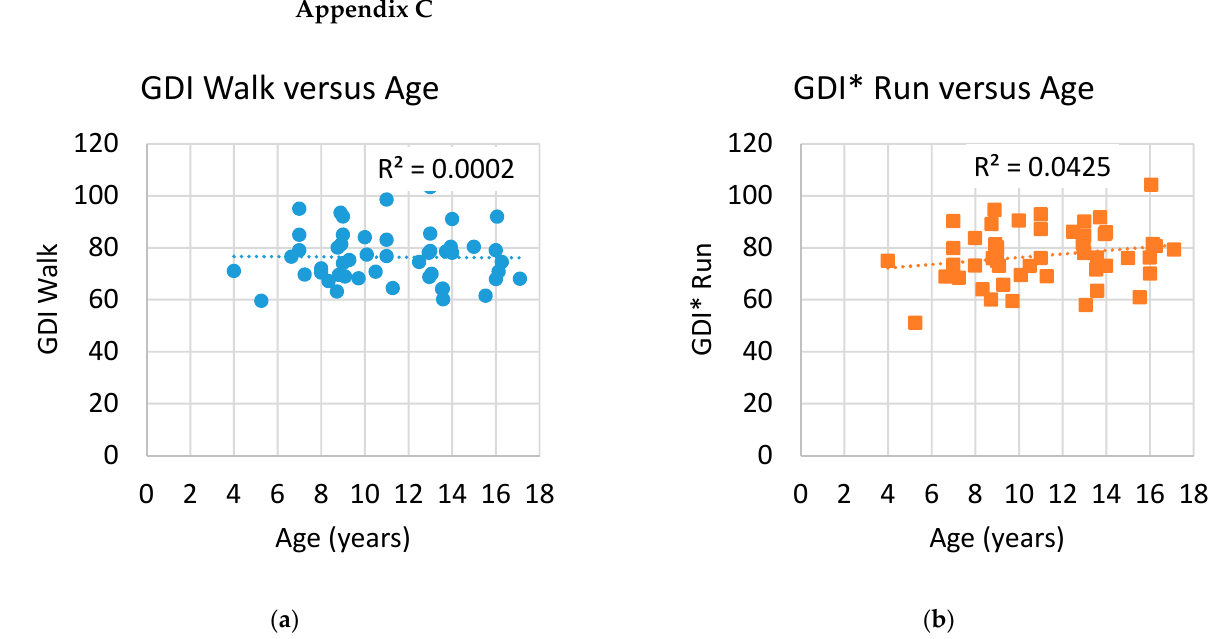
Figure A3. Values indicate that there is no correlation between GDI walk and age ( a ), and no correlation between GDI* run and age ( b ). This indicates that there is no improvement in walking or running quality as the age of the participants increases.